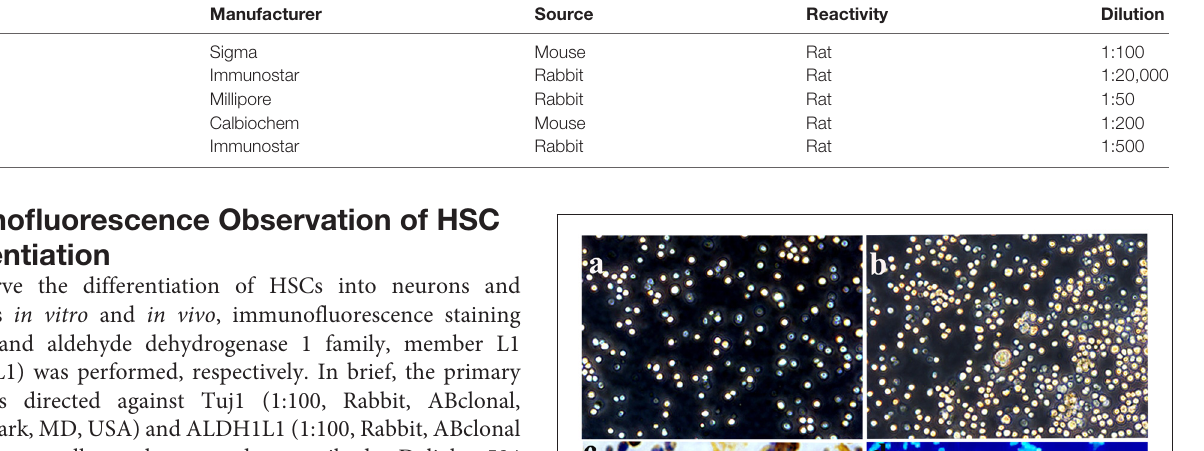
TABLE 2 | Antibodies used in the study. Antibodies Manufacturer